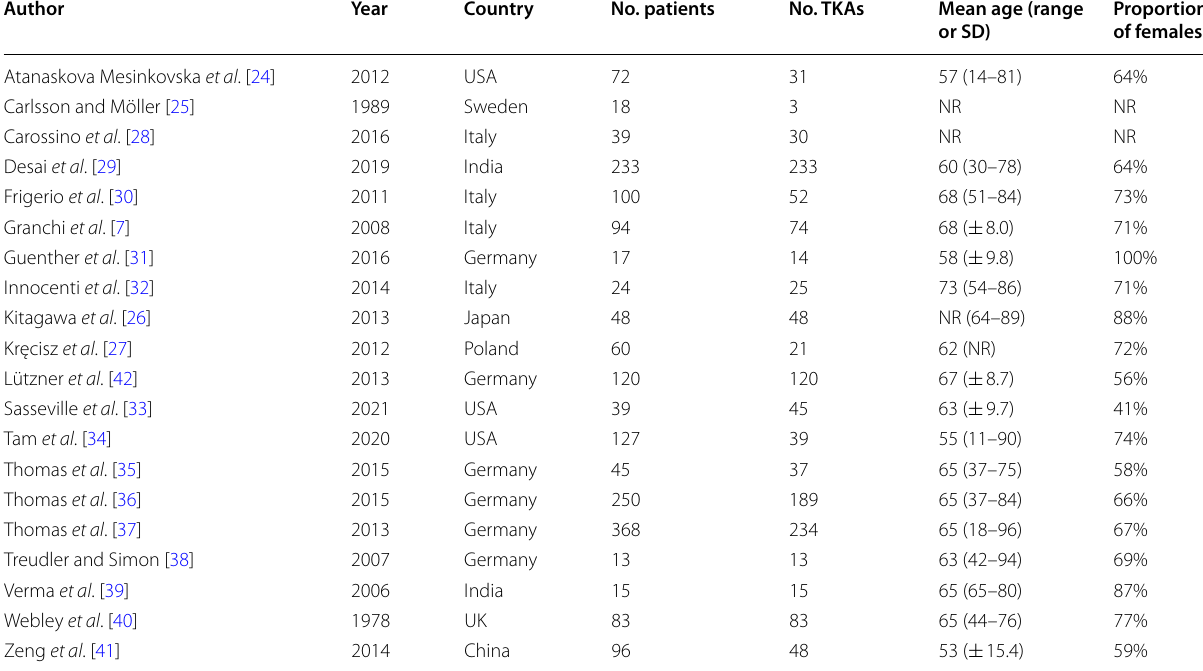
Table 2 Study characteristics with year, country, number of patients, number of total knee arthroplasties (TKAs), mean age (range or SD), and proportion of females